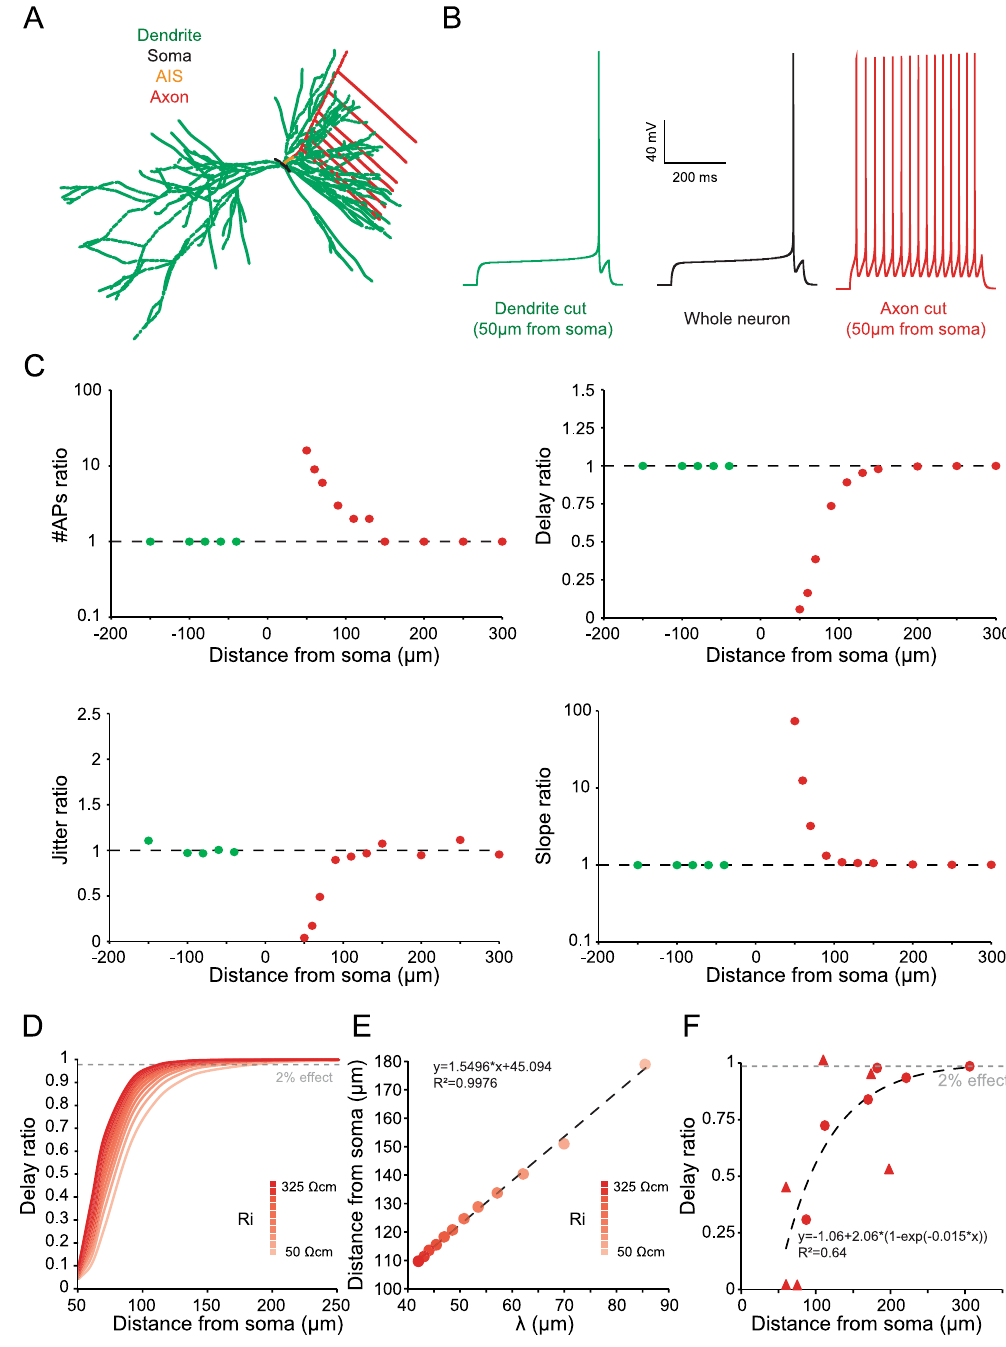
Figure 6. Modelling study of axon and dendrite cuts. ( A ) Drawing of the computational model. ( B ) Effect of axonal or dendritic cut on excitability and first spike delay during a 1 s current injection. Note the increase of AP number and decrease of first spike delay after axonal cut. ( C ) Spatial effect of axonal or dendritic cutting on number of APs, first spike delay, first spike jitter and depolarizing slope before the first spike during a 1 s current injection. Note that the model reproduces the experimental results of Fig. 3D. ( D ) Spatial extent of spike delay decrease by axonal cutting with various intracellular resistivity (R i ). Note that the larger the R i , the shorter the spatial extent. ( E ) Distance of axonal cut to get a 2% spike delay decrease as a function of space constant ( λ ). Note the linear relationship. ( F ) Fit of experimental data of delay reduction by axonal cutting (from Fig.